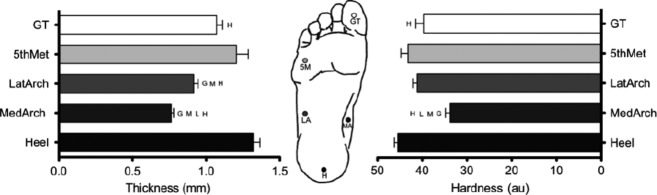
Mean skin thickness and hardness across the foot sole with standard error. Circles represent the test site. G, M, L and H denote significantly lower mechanical property measures than the GT, 5th Met, LatArch, and Heel, respectively (P < 0.05).